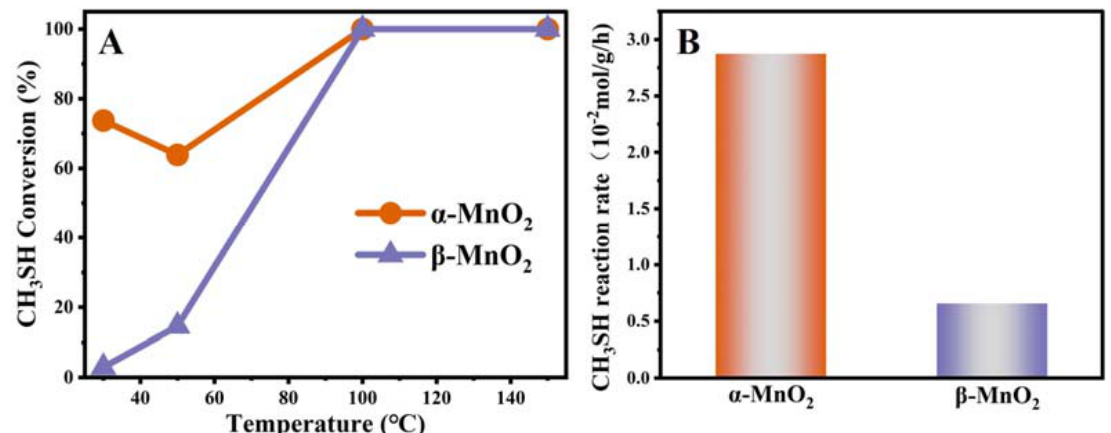
Figure 5. CH 3 SH degradation over α -MnO 2 and β -MnO 2 catalysts ( A ). Reaction condition: 0.20 g catalysts, 5000 ppm CH 3 SH, total flow rate = 30 mL min − 1 , WHSV = 9000 mL g − 1 ·h − 1 ); The reaction rates (×10 − 2 mol g − 1 h − 1 ) at 50 °C for α -MnO 2 and β -MnO 2 ( B ).